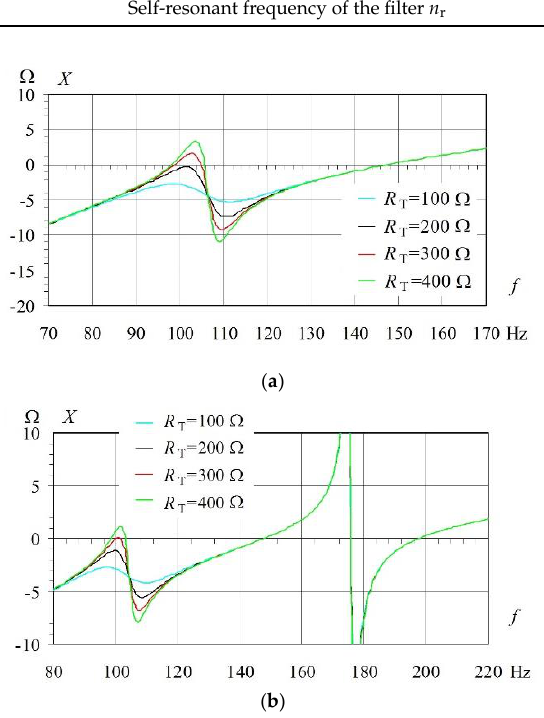
Figure 6. Equivalent reactance of the harmonic filters as a function of frequency at different resistance values of the damping resistor in a C-type filter. ( a ) Second and third filter. ( b ) Third and fourth filter. Table 2. Parameters of the transmission system and the transformer.